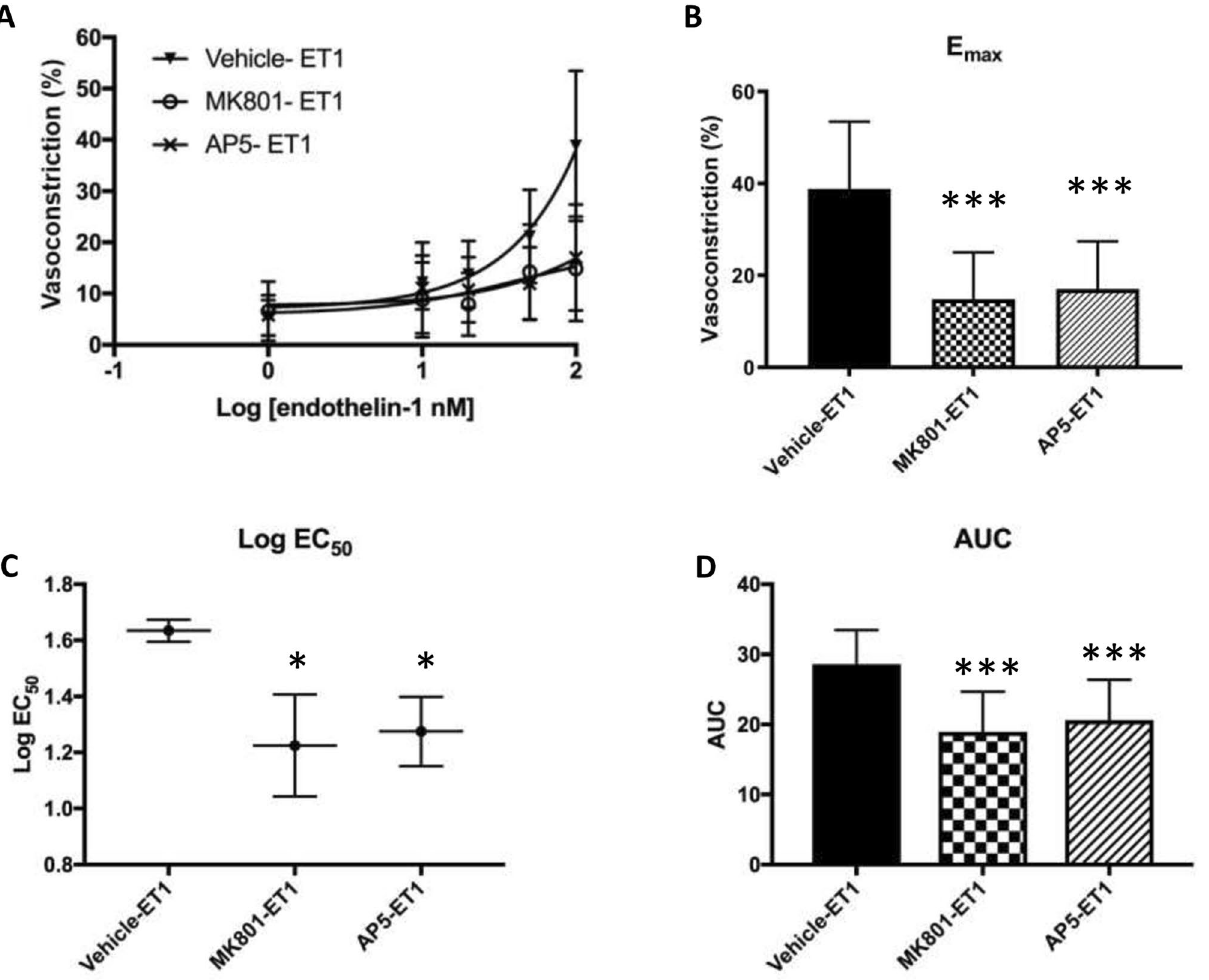
Figure 8[replace with the revised figure]. NMDA receptors regulate endothelin-1 (ET-1)-induced pulmonary vasoconstriction in murine precision-cut lung slices. ET-1 induced pulmonary vasoconstriction under a normoxic (21% O 2 ) condition in a dose-dependent manner ( A ). Pretreatment with 10 µM MK801 or 50 µM AP5 significantly attenuated ET-1-induced maximal vasoconstriction (E max ) ( B ), the sensitivity of